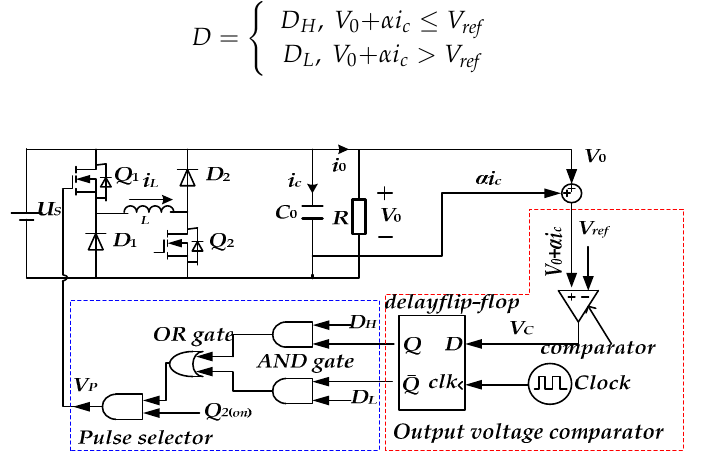
Figure 5. The structure of SRG power system under the control of CC-PT.